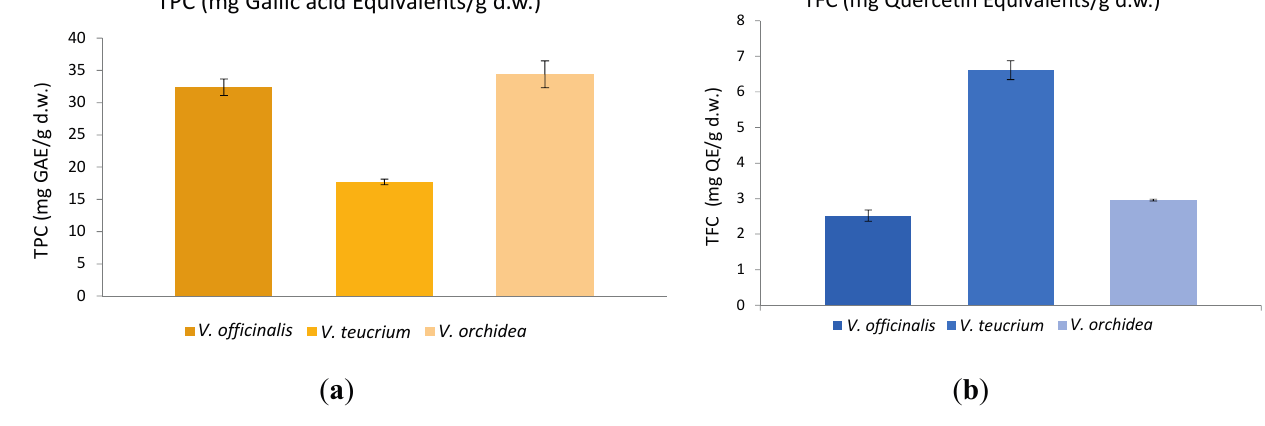
Figure 3. ( a ) Total phenol content (TPC) and ( b ) total flavonoid content (TFC) of Veronica species (the bars indicate mean ±